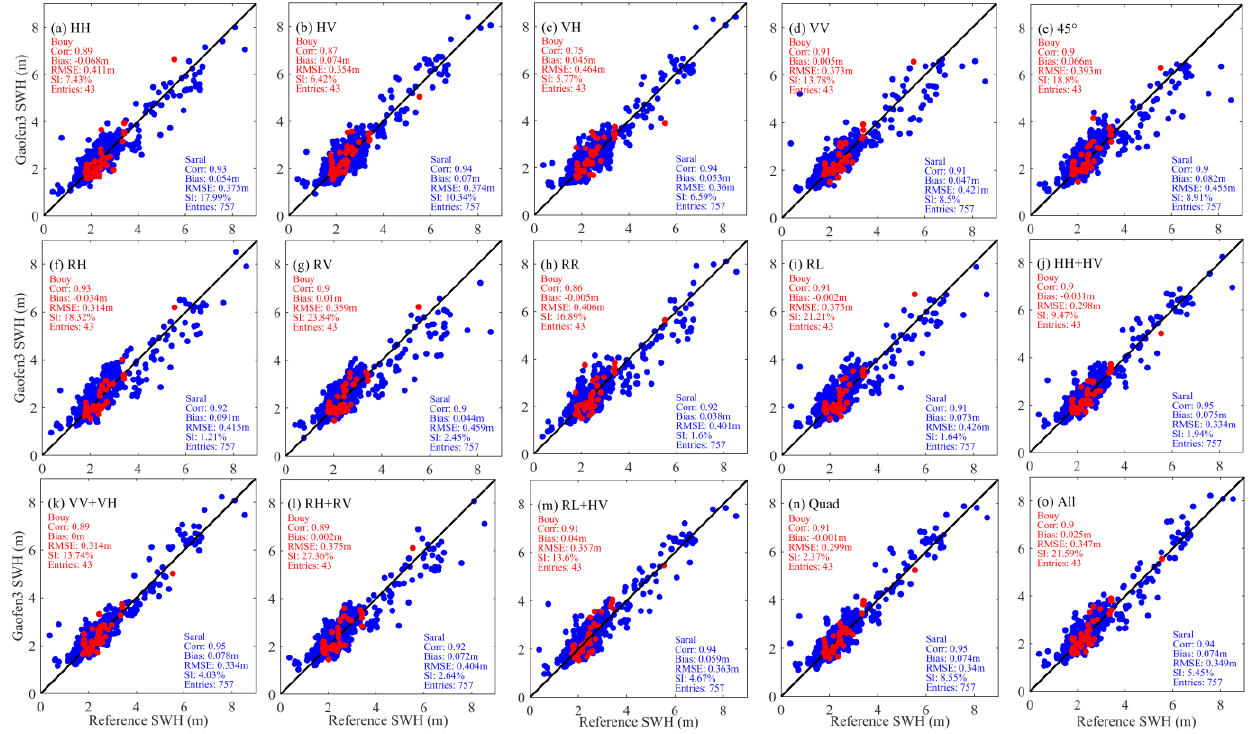
Figure 10. Plots of Gaofen-3 SWH retrievals from XGBoost models using optimal feature sets versus SWH measurements from buoys (red) and Saral (blue) for the 15 polarization modes of ( a ) HH, ( b ) HV, ( c ) VV, ( d ) VH, ( e ) 45° linearly, ( f ) RH, ( g ) RV, ( h ) RR, ( i ) RL, ( j ) HH + HV, ( k ) VV + VH, ( l ) RH + RV, ( m ) RL + HV, ( n ) Quad, ( o ) All.